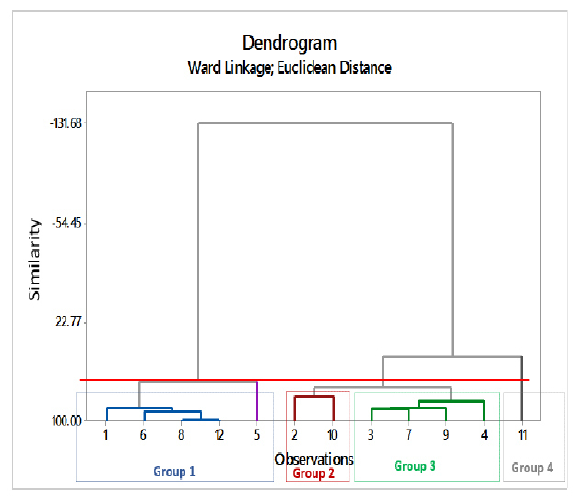
Figure 2. Dendrogram showing the similarity among asparagus producing farms of the Chavimochic irrigation project in